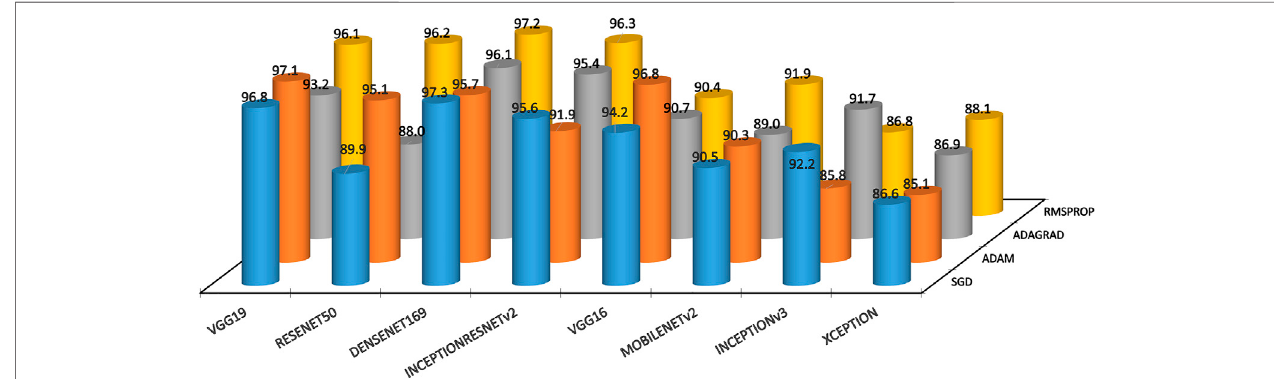
FIGURE 4 | Testing accuracies for multi-class classi fi